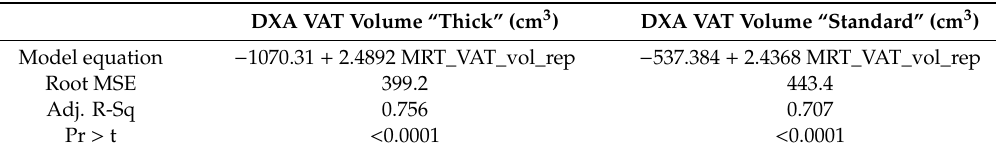
Table 4. Relationship between volume of VAT measured by MRI (MRT_VAT_vol_rep) and DXA “thick” mode and DXA “standard”